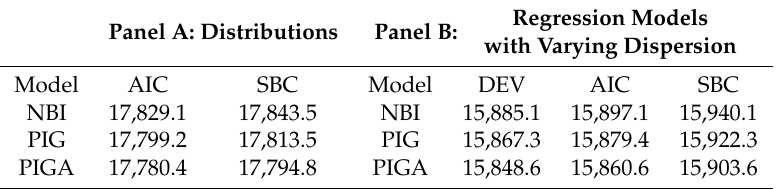
Table 4. Models comparison.